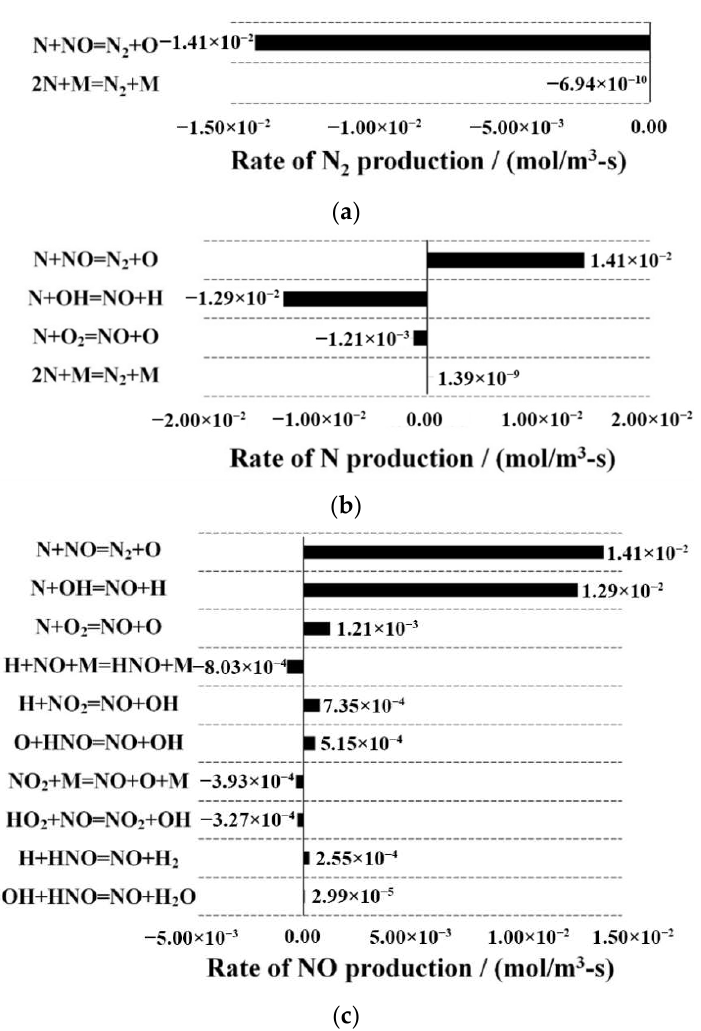
Figure 5. Production rate of dominant nitrogenous species of different reactions. ( a ) Production rate of N2. ( b ) Production rate of N. ( c ) Production rate of NO. The hybrid H 2 –air reaction equations of 11 species and 15 reactions, where the high- temperature air reactions (No. 1~7), H 2 –O 2 combustion reactions (No. 9~15), and the effect of nitrogenous reaction (No. 8) on the combustion, are considered as listed in Table 4. Table 4. Hybrid H 2 –air chemical reaction equations. No.